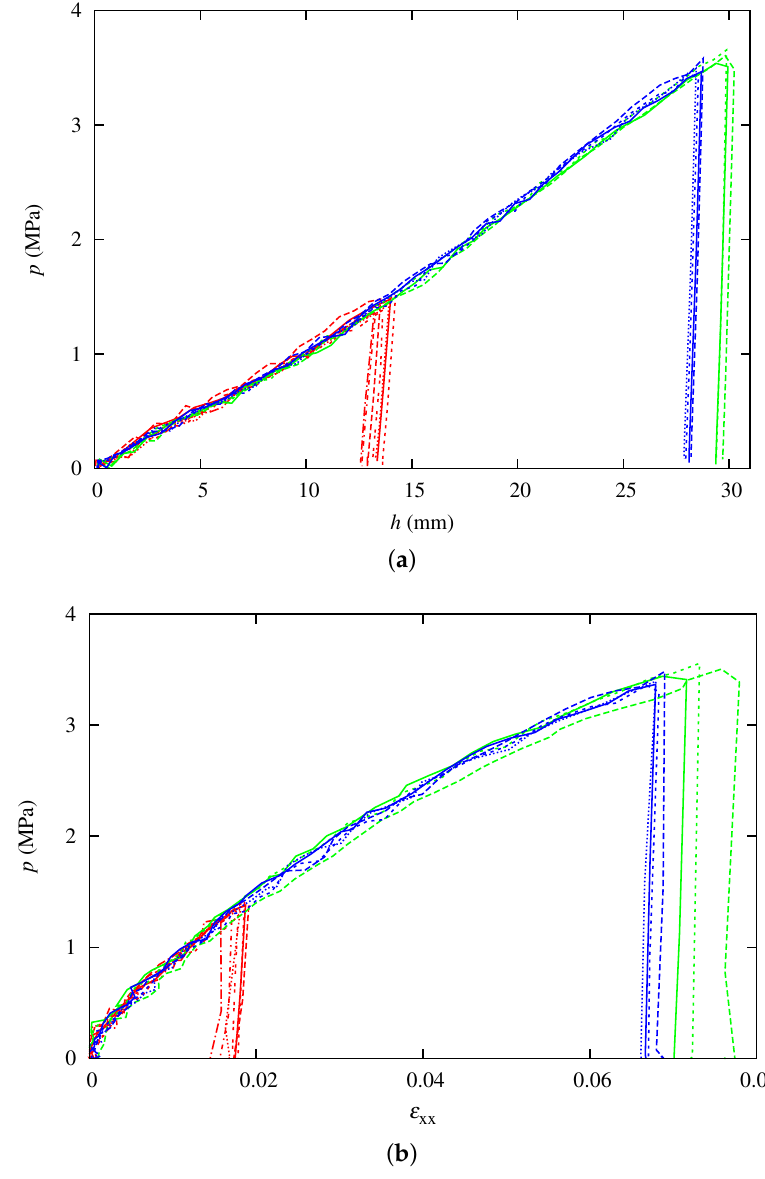
Figure 7. Bulge test. Each colour and line type stands for a single test. The tests can be gathered around the maximum pole height: 13mm in red, 28mm in blue and 29.5mm in green. ( a ) Evolution of the fluid pressure as a function of the maximum height, as measured on the outer surface; ( b ) evolution of the fluid pressure as a function of the strain component (cid:101)